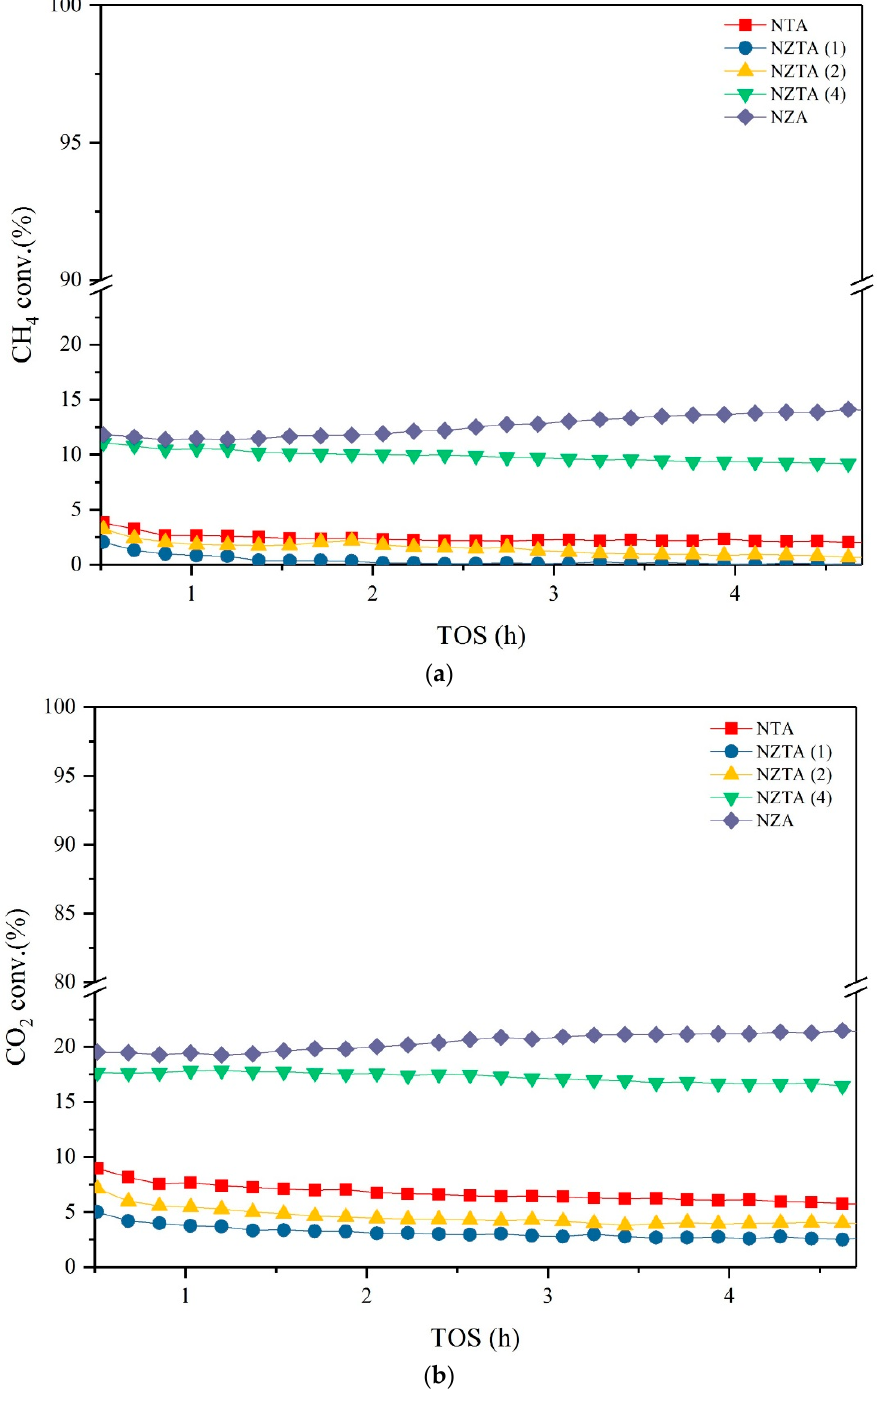
Figure 7. Catalytic performance of the prepared catalysts with different Zr/Ti ratio under the tested conditions for 5 h ( a ) CH 4 conversion (%) ( b ) CO 2 conversion (%).